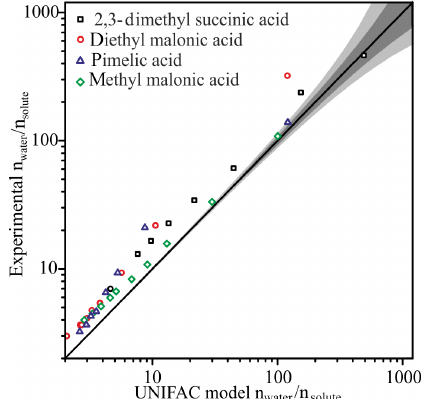
Figure 7. Comparison of the experimentally determined number of moles of water per mole of solute and the value predicted from UNIFAC for the four dicarboxylic acids with the largest deviation from UNIFAC. Shaded regions correspond to error in a w of ± 0.001 (shaded dark grey regions) and ± 0.002 (shaded light grey